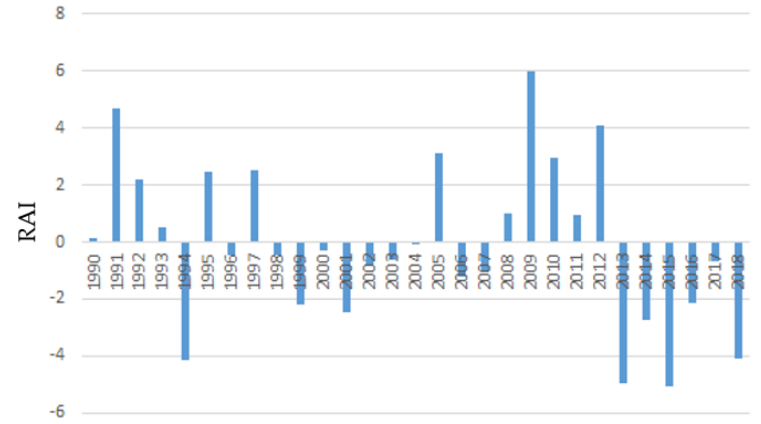
Figure 2. Rainfall anomaly index (RAI) for the Tokat province.